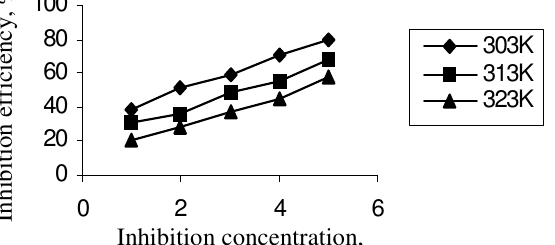
Figure 4. Variation of inhibition efficiency (%) with inhibitor concentration (M) for mild steel coupons in 2M HCl solutions containing 2-benzoylpyridine at different temperatures